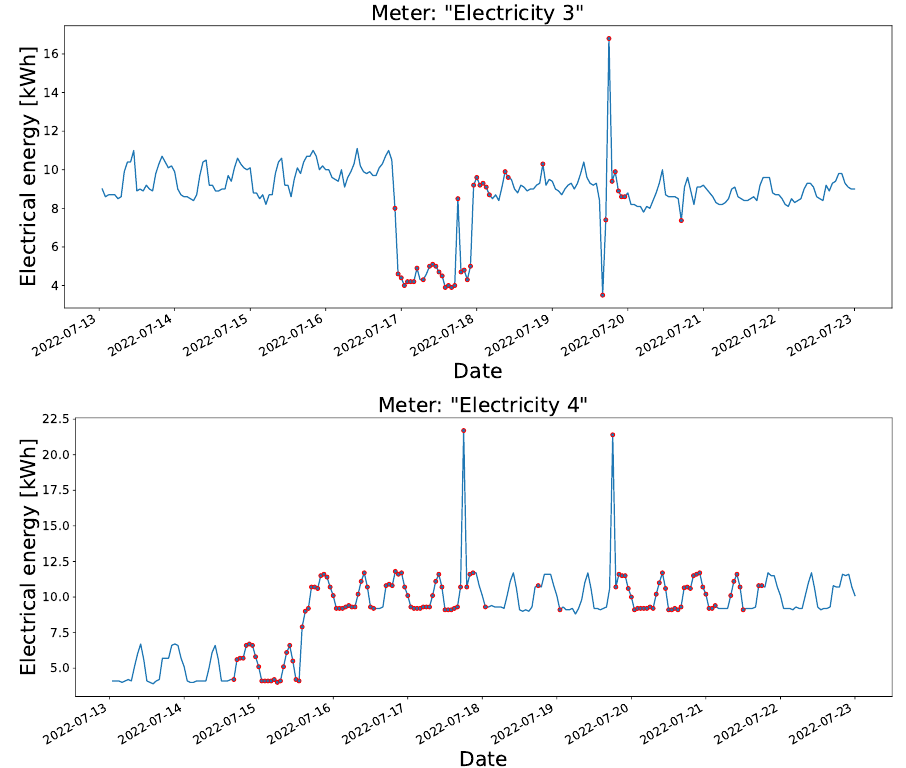
Figure 17. Real anomaly detection scenarios detected by the proposed system. The first scenario ( top ) is associated with a machinery failure, and the second one ( bottom ) is related to one water pump that started working on a new unnecessary